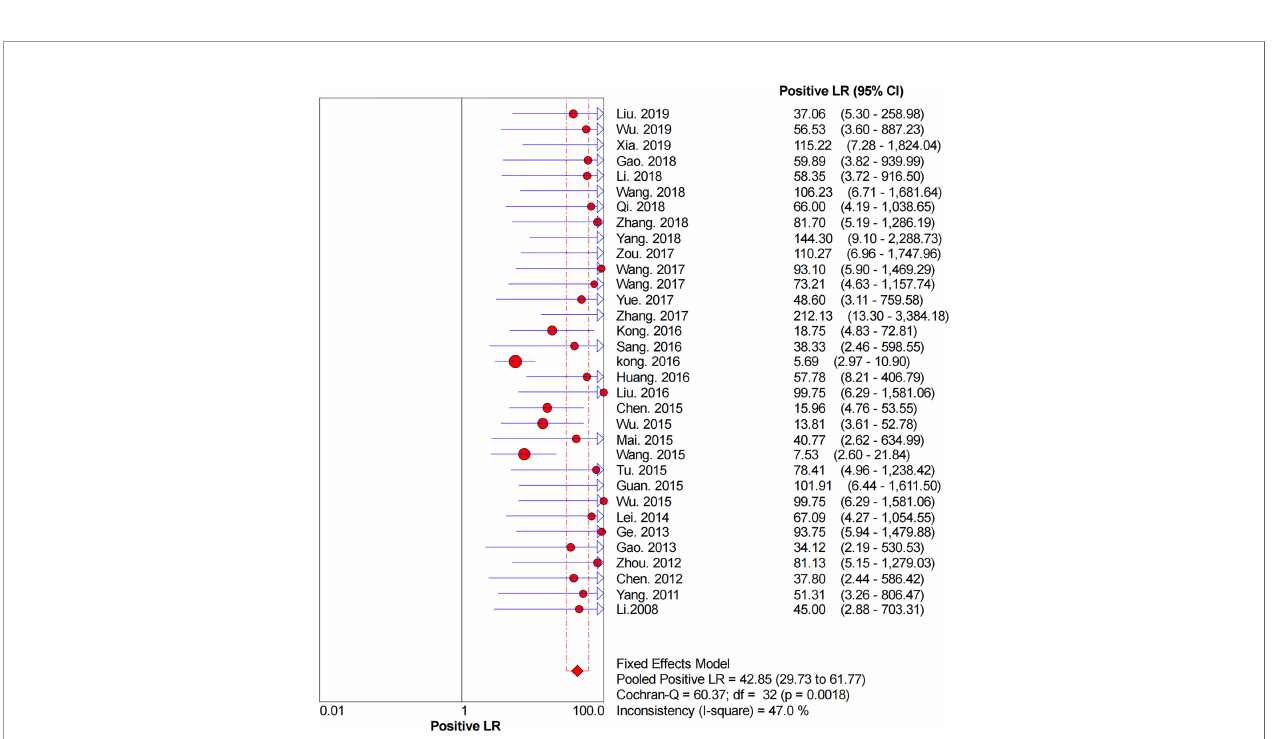
FIGURE 4 | Forest plot of pooled PLR of the diagnosis value of CNSs in SLNB of breast cancer. 95% CI, 95% con fi dence interval; PLR, positive likelihood ratio.